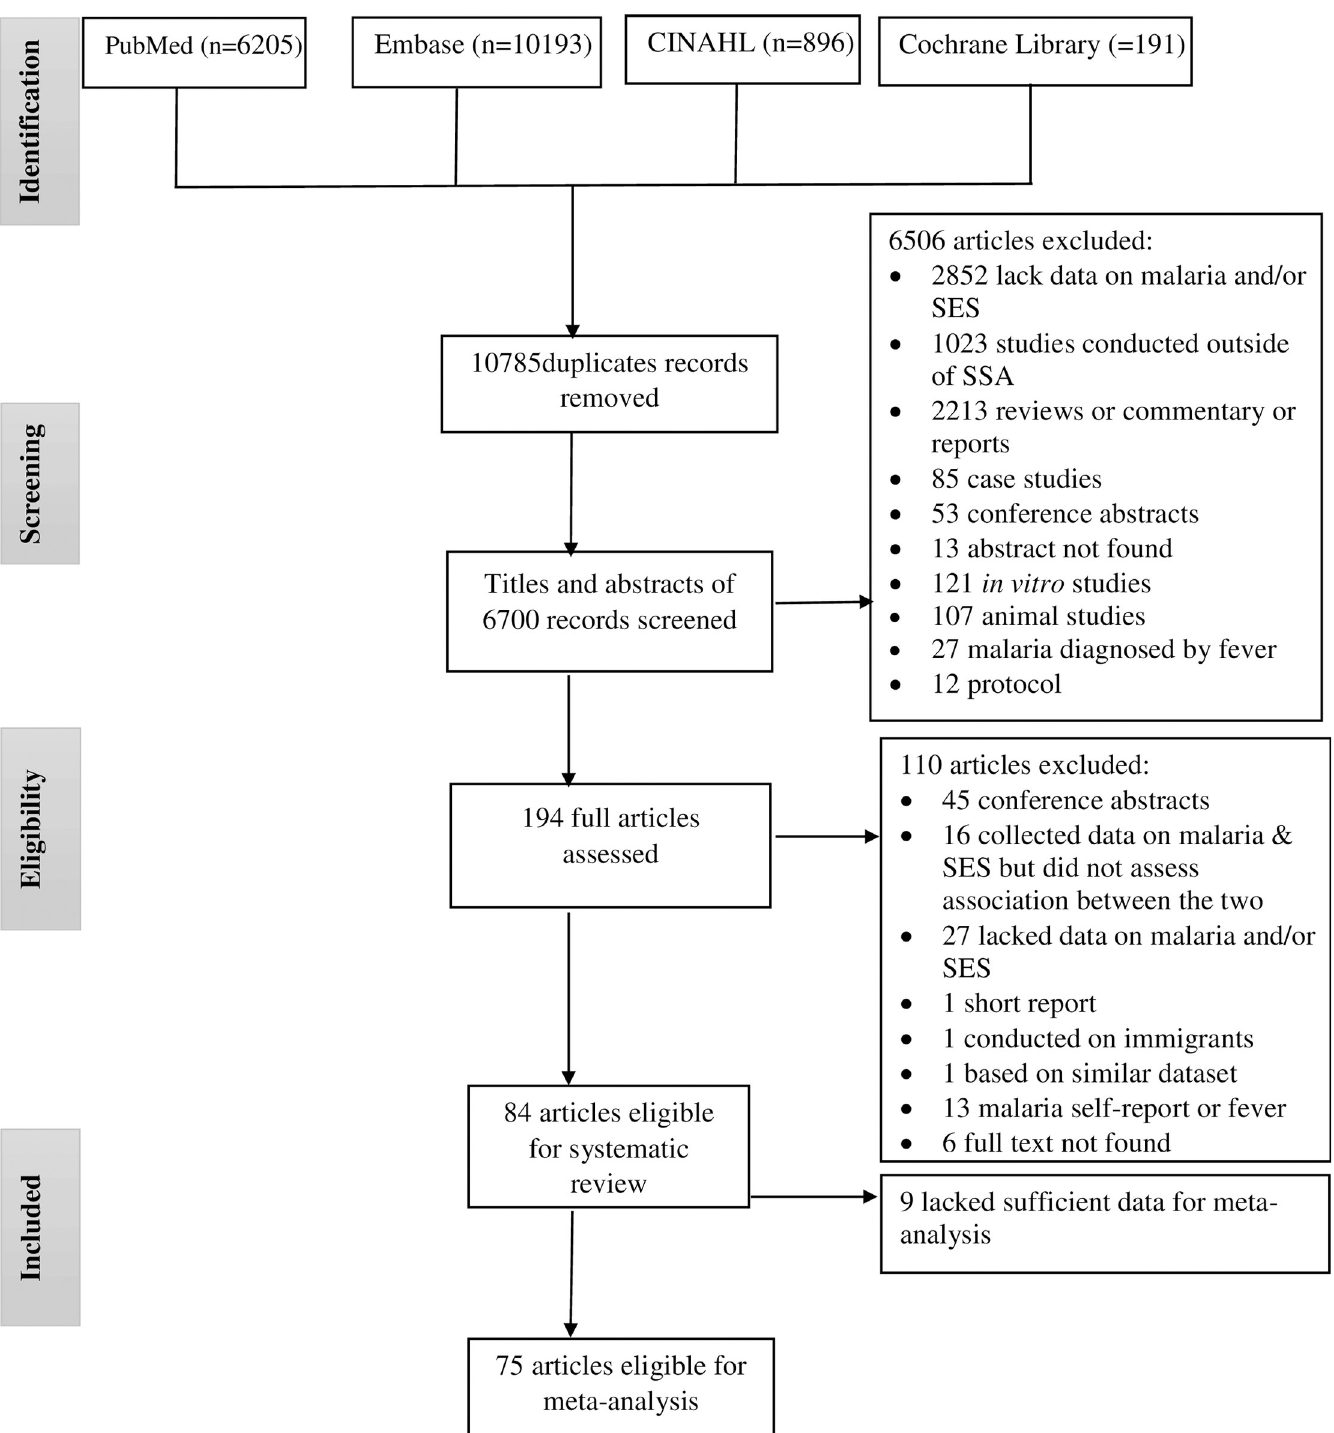
Fig 1. PRISMA flow diagram showing the number of articles retrieved, screened, excluded, and included at each stage of the search of published articles examining the relationship of socioeconomic status with the epidemiology of malaria in sub-Saharan Africa.